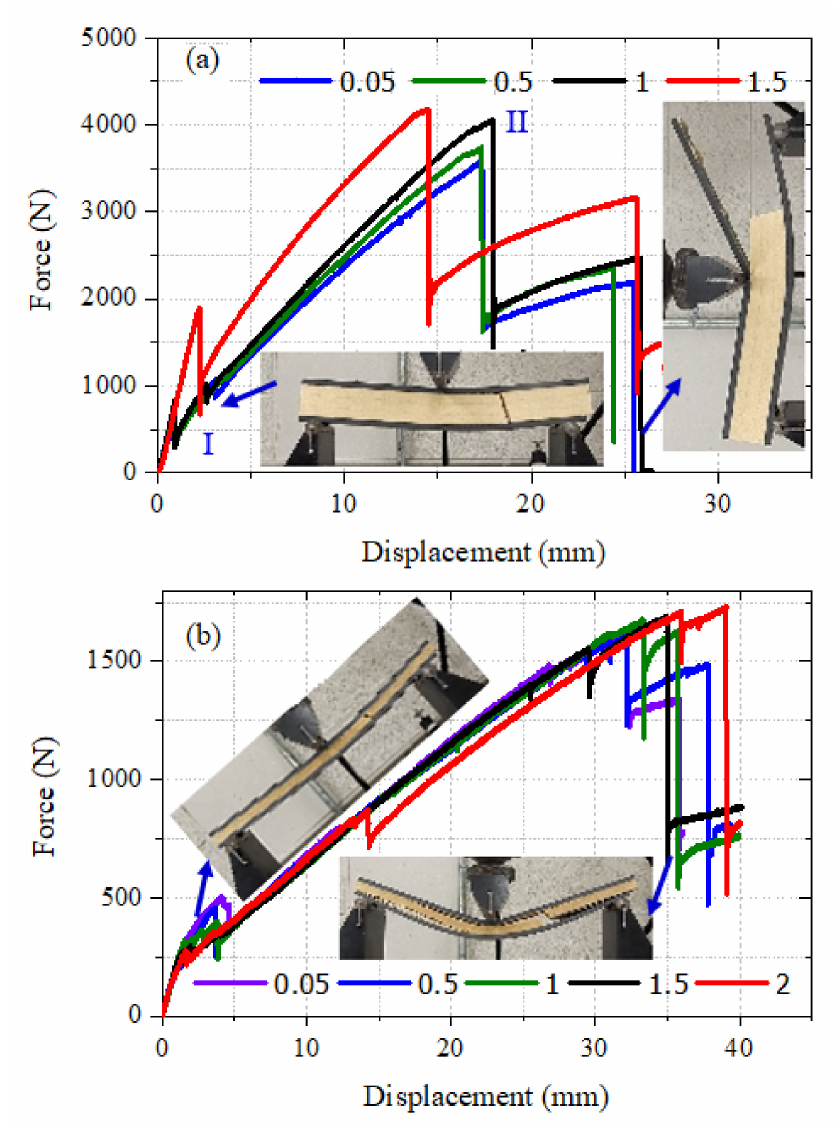
Figure 6. E ff ect of displacement rate on a CFRP facesheet / PU foam sandwich beam that had a core thickness under three-point loading at a span length of 9 inches; ( a ) 29 mm and ( b ) 9